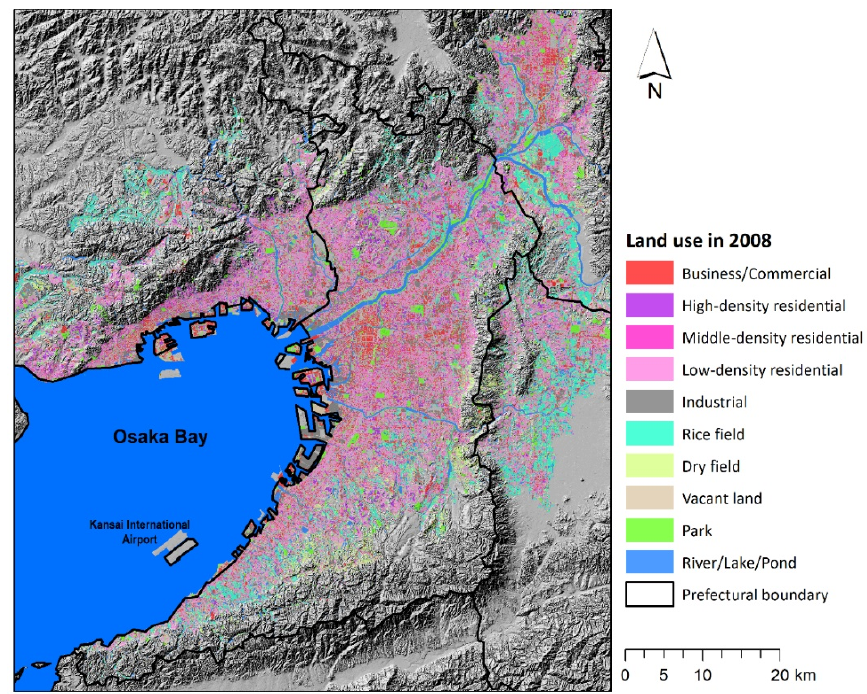
Figure 2. Osaka Prefecture (our study area) and its surrounding land uses [40] on terrain relief showing an urbanization gradient from the urban center toward suburban hill and mountain areas within a natural landform boundary of mountain ridges and a bay area.